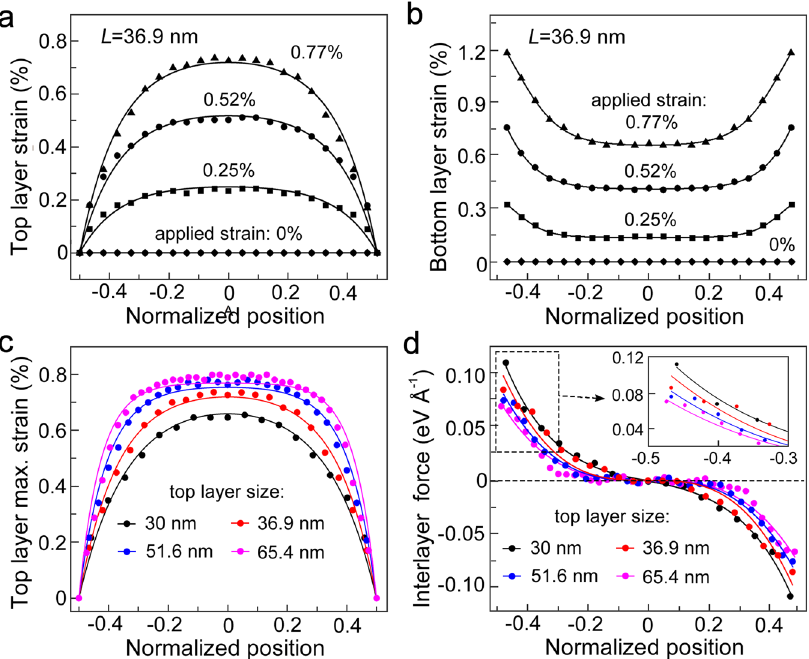
Fig. 3 Simulated strain distribution and interlayer shear force along the tensile direction by MD. a , b Calculated strain distributions of the top and bottom graphene layers along the tensile direction, respectively. c Strain distributions in top layers and d interlayer force distributions at the vdW interface along the tensile direction with different top graphene layer